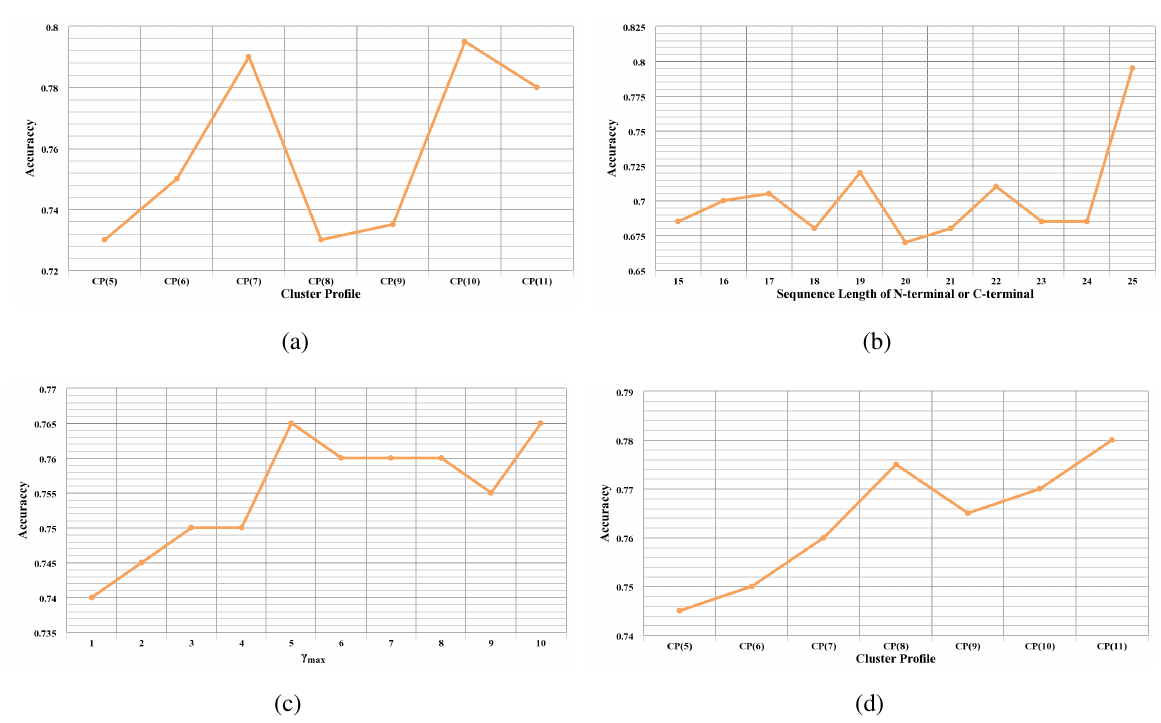
Figure 2. Prediction accuracy of individual feature spaces with different parameters. ( a ) Prediction accuracy of CTD with different cluster profiles; ( b ) prediction accuracy of bi-profile Bayes with different lengths of the N-terminus and C-terminus; ( c ) prediction accuracy of PseAAC with different tier correlation factors γ ; ( d ) prediction accuracy of PSSM with different cluster